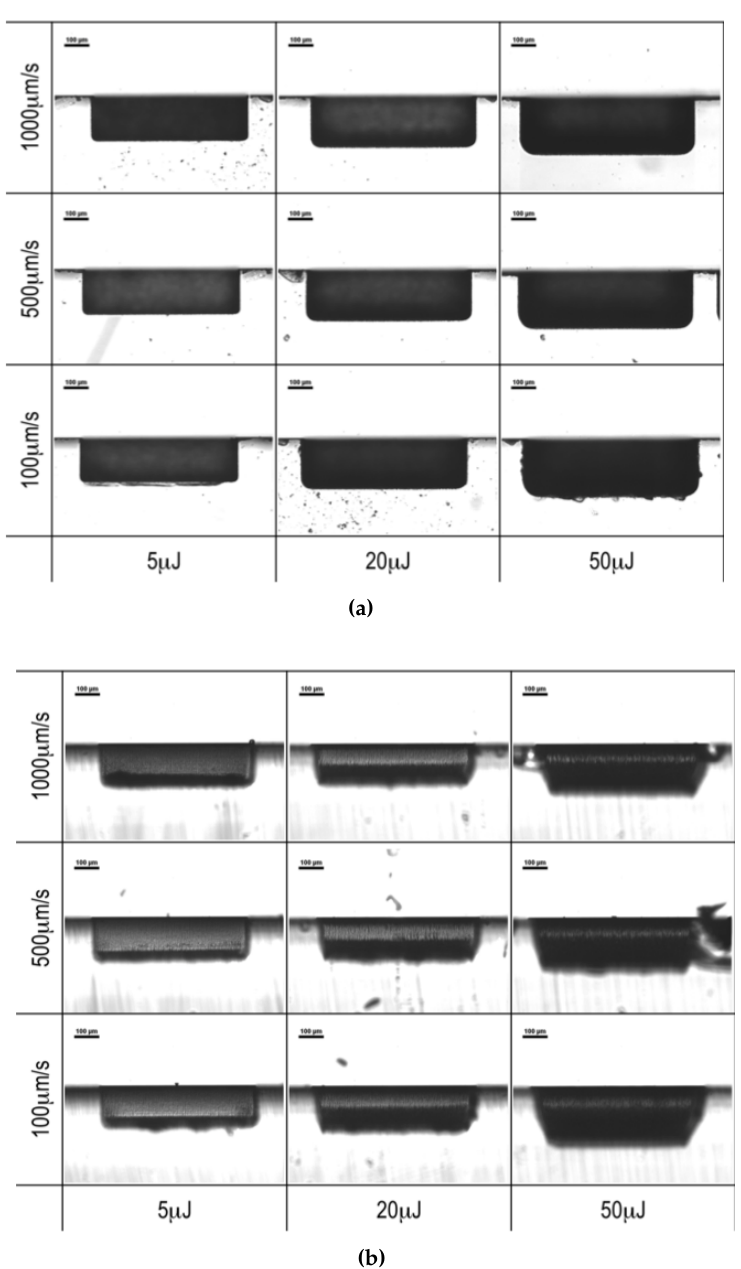
Figure 3. Micrographs of ( a ) the upper edges (+ x face) and ( b ) the lateral walls ( − y face) of the test channels engraved by laser ablation on an x -cut lithium niobate (LN) wafer. The images are ordered according to the pulse energy and the scanning speed of the laser beam along the horizontal and vertical axes,